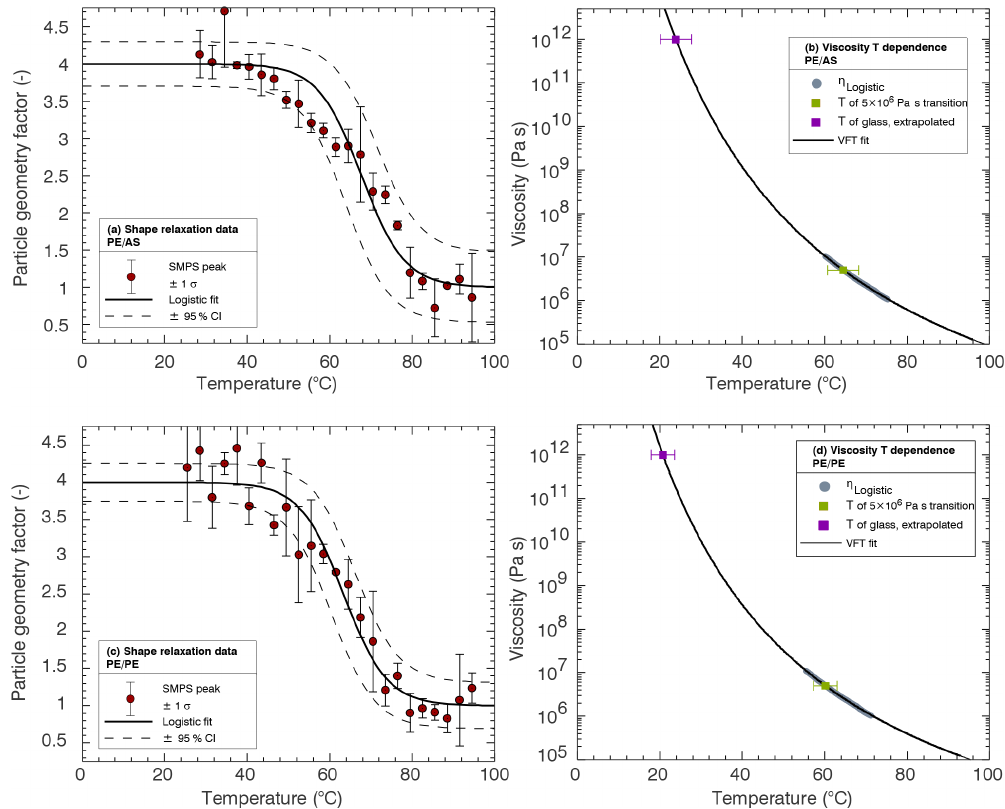
Figure 2. (a, c) Shape relaxation data for PE / AS (a) and PE / PE (c) 50nm / 50nm dimers. Symbols are the mean geometry factor derived from the temperature binned mode diameter peaks. Vertical bars are the standard deviation. Dashed lines correspond to the 95% confidence interval of the relaxation temperature derived from the fit. (b, d) Temperature dependence of viscosity for PE / AS (b) and PE / PE (d) ex- periments. The solid line gives the VFT fit. Gray circles correspond to values where 1 > ξ > 4. The green and purple symbols correspond η = 5 × 10 6 and 10 12 Pas, respectively. Horizontal error bars correspond to the 95% confidence interval of the relaxation temperature derived from the fit. Parameters corresponding to the logistic and VFT fits are given in Table 1. Table 1. Tabulated values for viscosity experiments. Symbols not defined above: (cid:49)T is the 95% confidence interval of T r determined from the fit, and RH is the relative humidity inside the coagulation